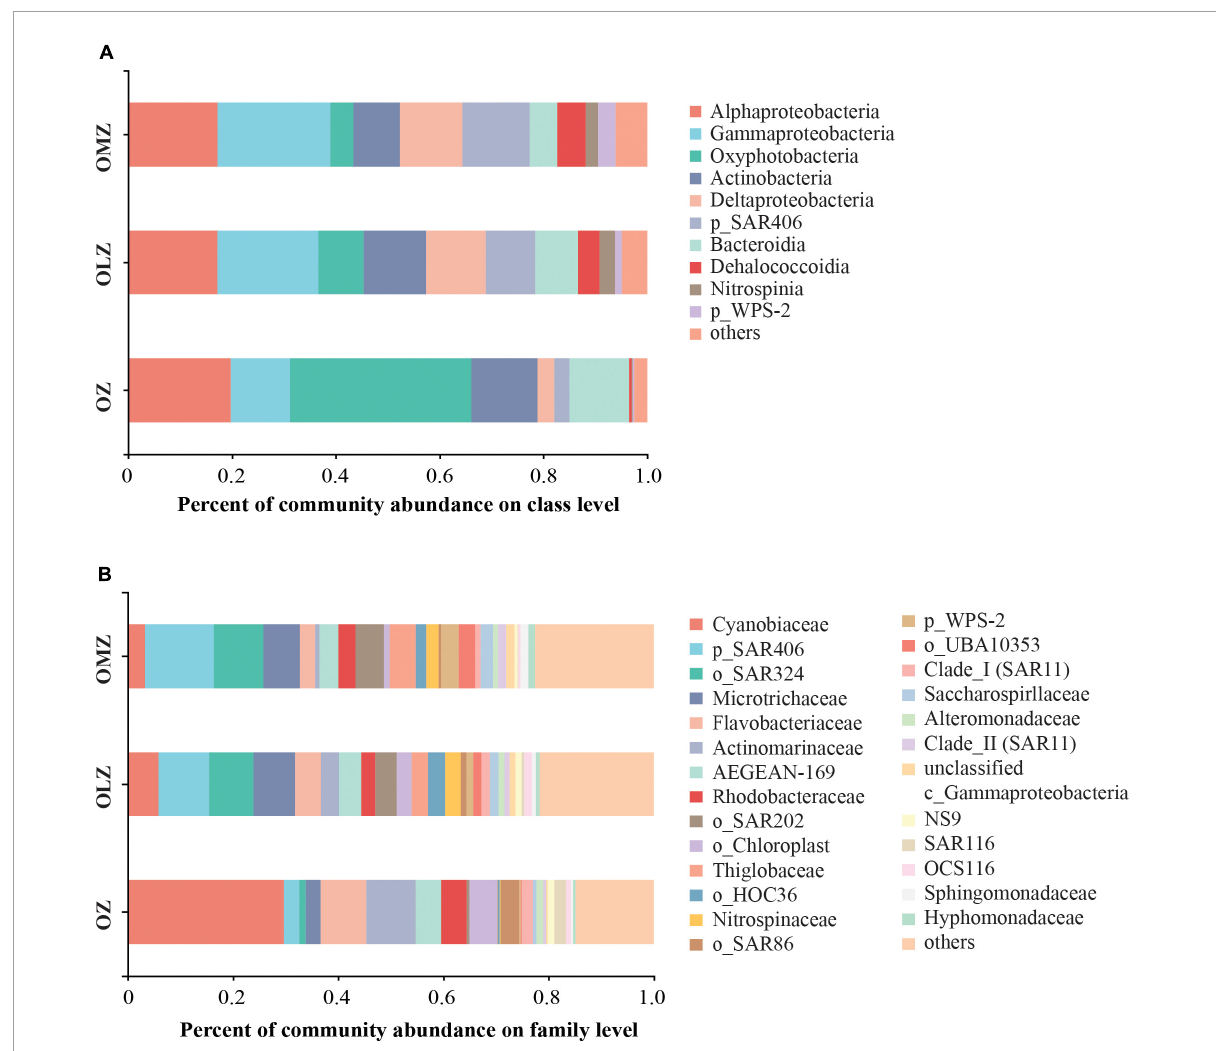
FIGURE3 Microbial community composition of OMZ, OLZ, and OZ waters at the class and family levels. Taxa are distinguished at the (A) class and (B) family level. p, phylum; o, order; c,